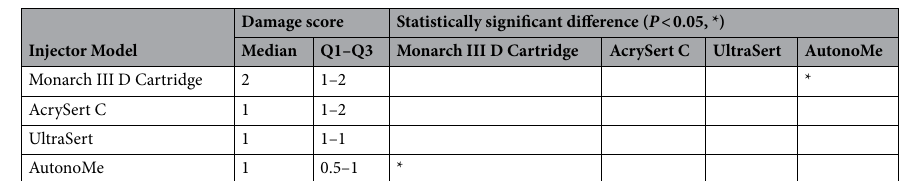
Table 2. Results of damage score for each injector